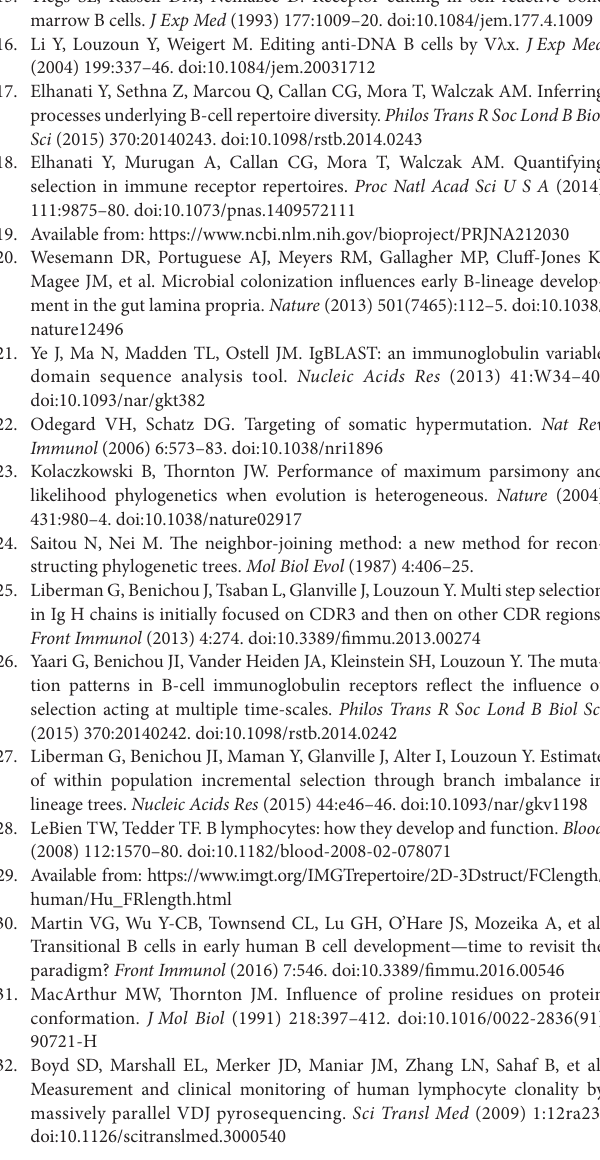
TaBle s1 | The samples that were used for each model and their quantity. In subsets of both the mouse data and of the human data, we perform the analysis only on the deterministic model because of small sample